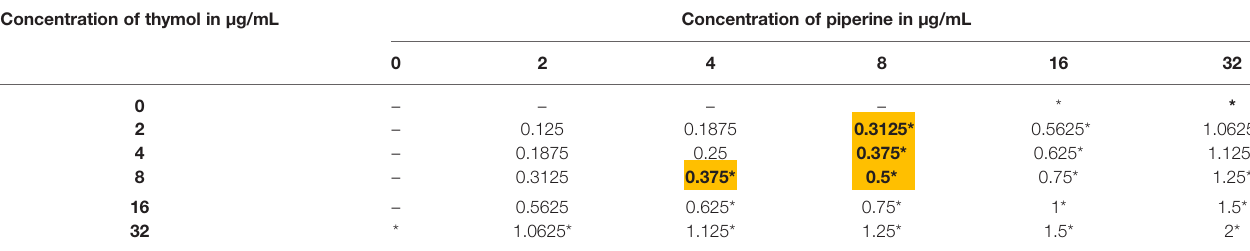
TheFICindicesofpiperineandthymolcombinationsatdifferentconcentrationsaretabulatedin Table1 .Thesign “ * ” indicatesthepresenceofantibio fi lmactivityinindividualandcombinationof drugs,and “ - ” indicatesthe absence of antibio fi lm activity. Theinhibitionof bio fi lm was observedatmost of the combinations,but the synergisticeffect ofpiperineand thymolwas observedat combinations of 8 + 8 µg/ml; 8 + 4 µg/ml; 8 + 2 µg/ml and 4 + 8 µg/ml of piperine and thymol with FIC indices of 0.5, 0.375, 0.3125 and 0.375 respectively